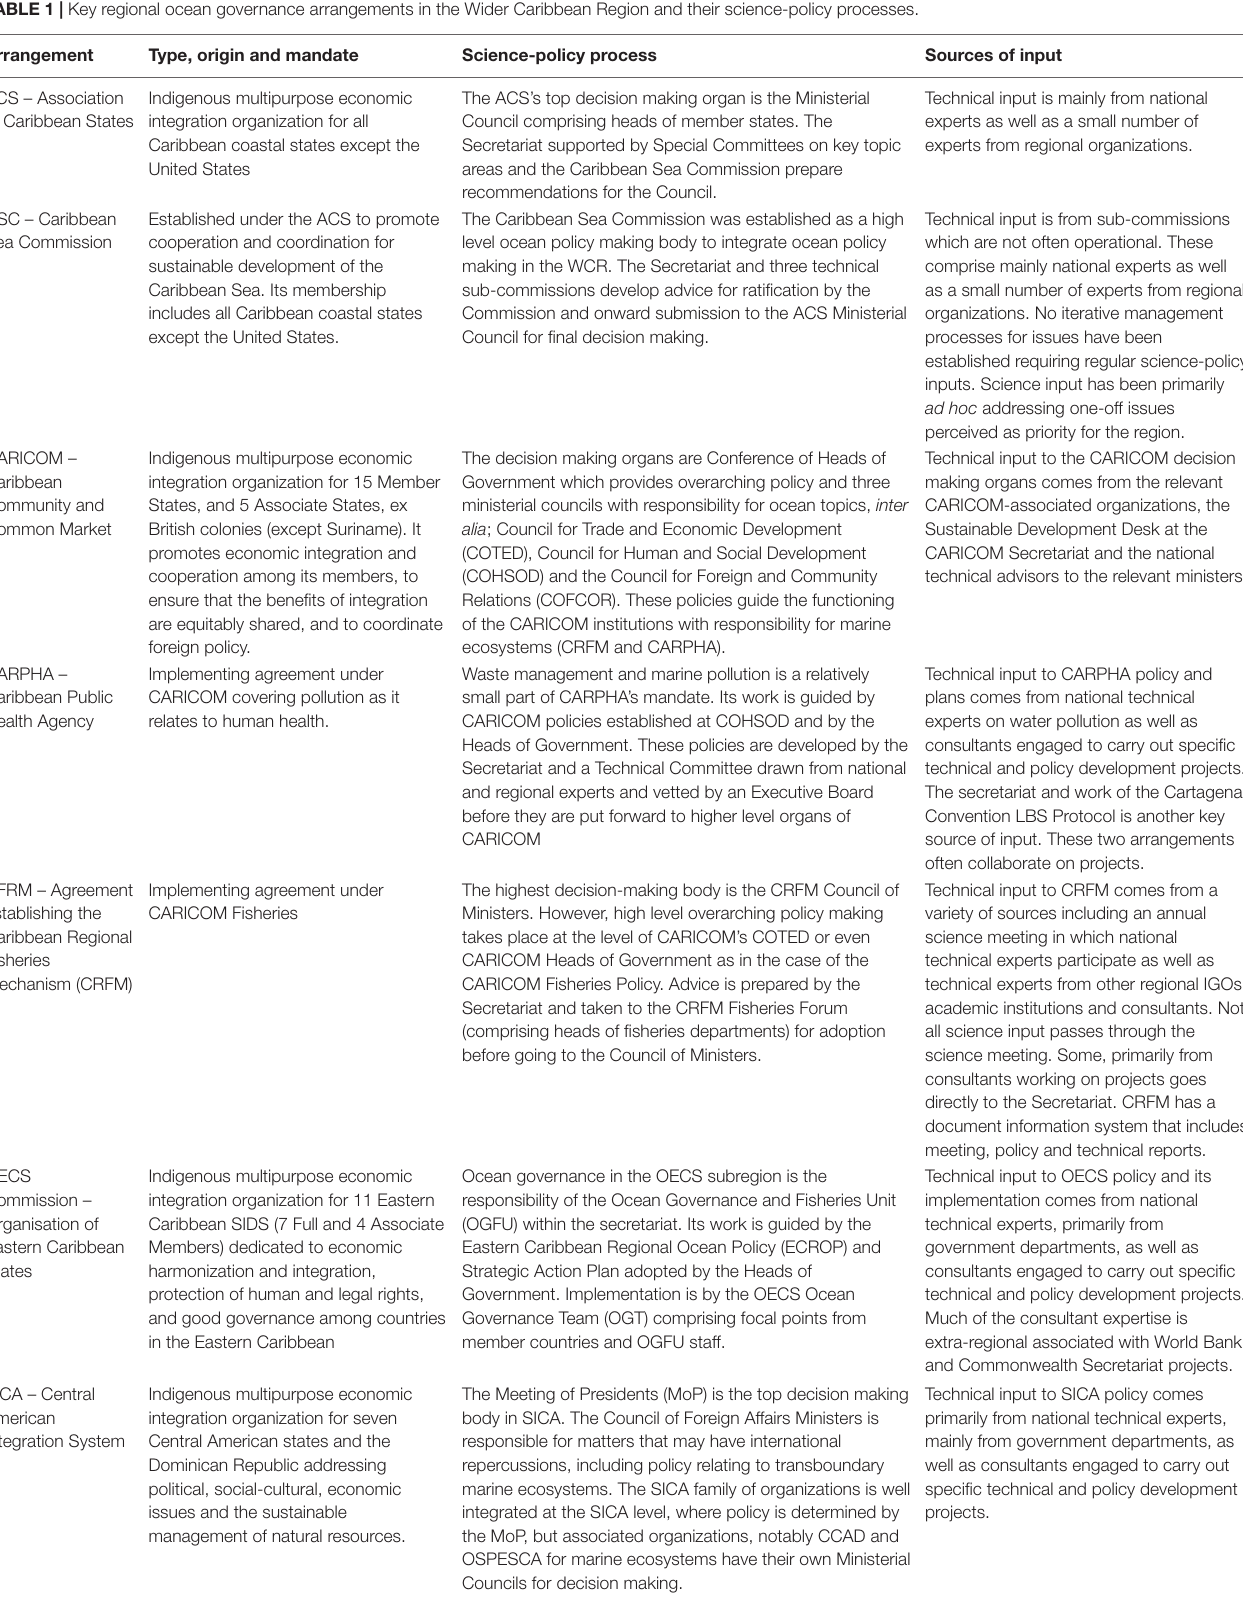
TABLE 1 | Key regional ocean governance arrangements in the Wider Caribbean Region and their science-policy